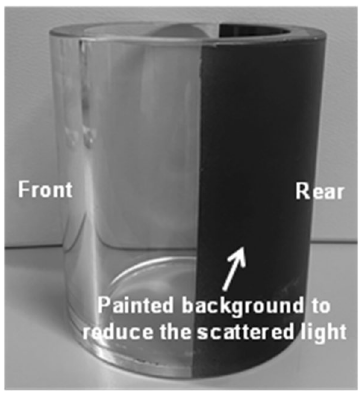
Figure 3. Quartz cylinder used to PIV